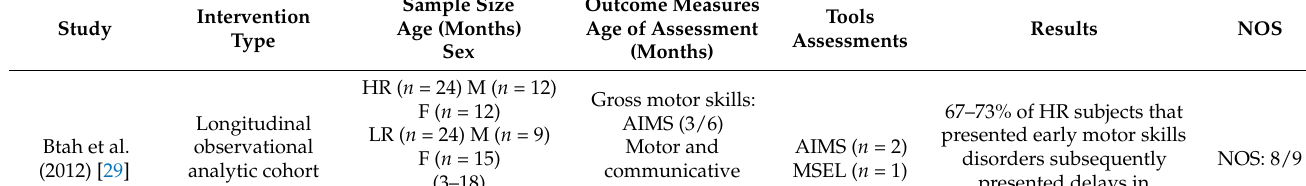
Table 1. Summary of